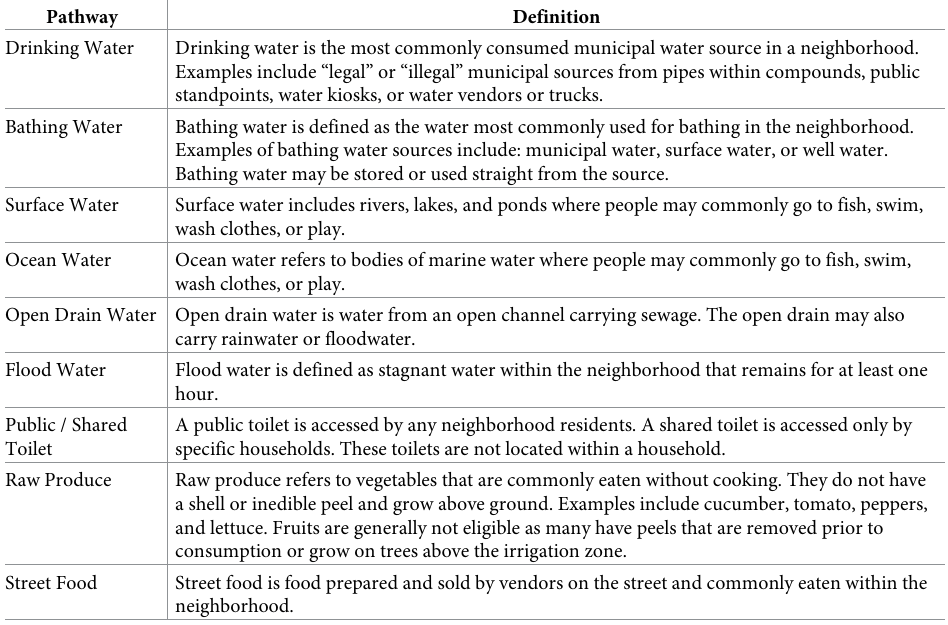
Table 1. Pathway types and definitions. The table below provides standard pathway definitions for a SaniPath deployment. Users may choose to adapt definitions to better fit their local contexts (e.g. different type of drinking water rather than municipal drinking water), however, the subsequent implications for interventions should be